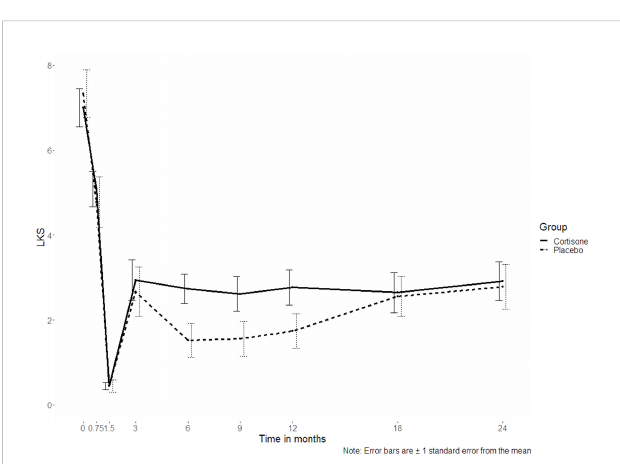
FIGURE 3 Line plots of the Lund-Kennedy score (LKS, p = 0.507); the dotted line represents the placebo group, the continuous line represents the steroid